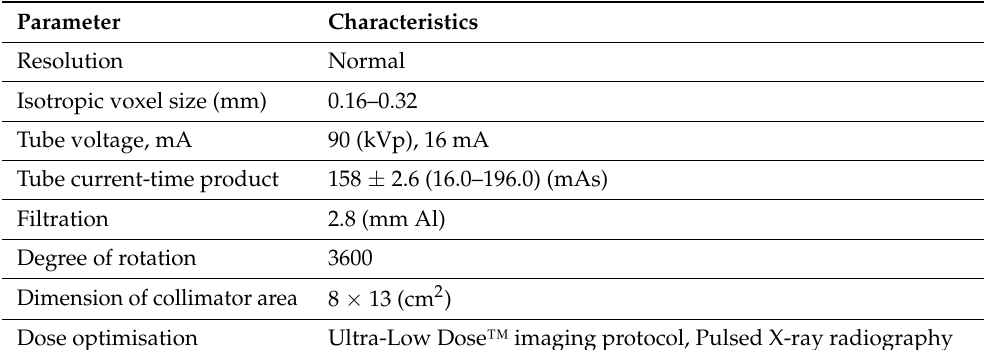
Table 1. Planmeca ProMax 3D Max features and exposure